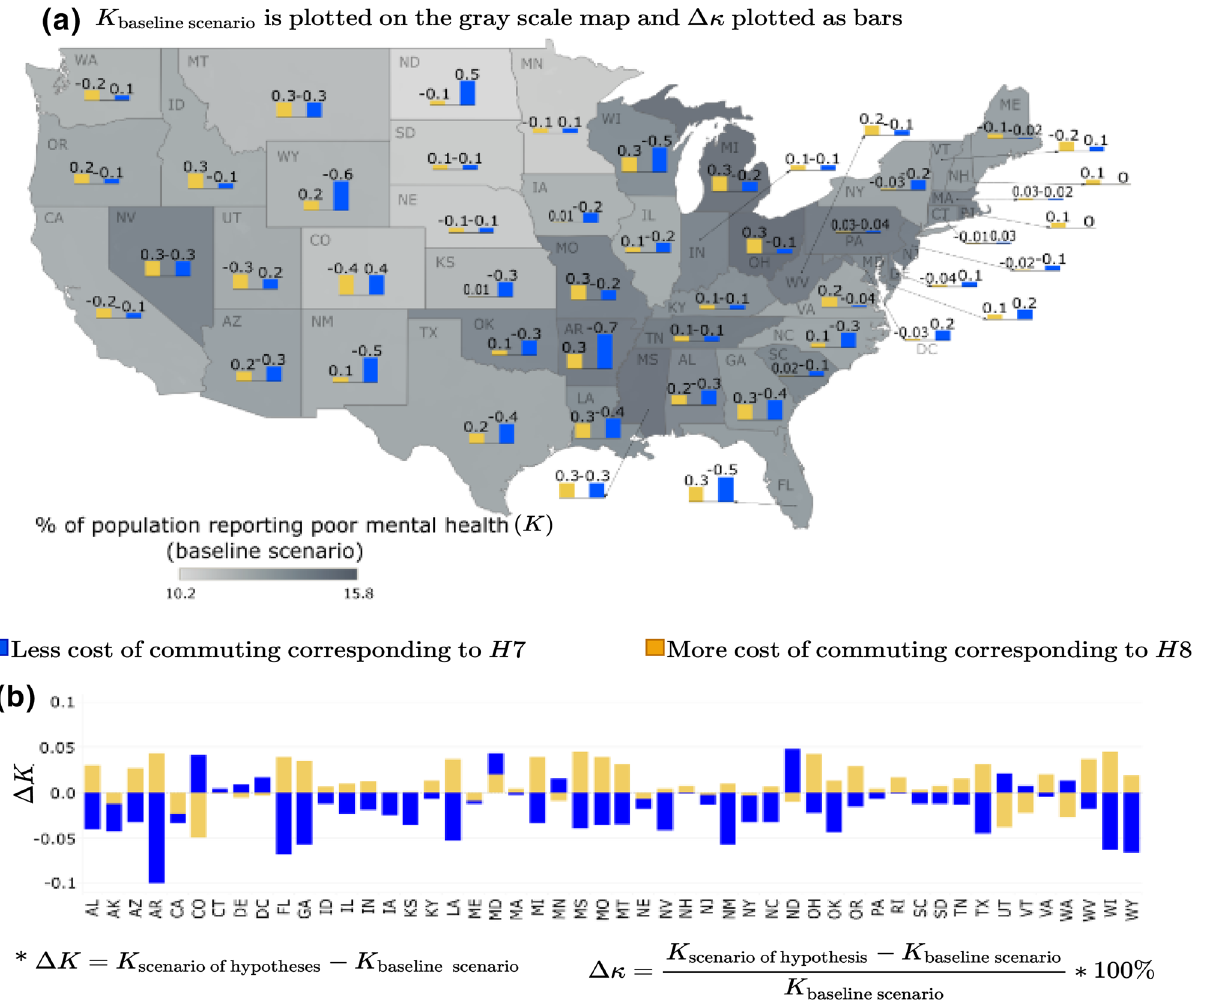
Figure 6. Travel cost scenarios for % of adults aged > 18 years reporting poor mental health for > 14 days ( K ): ( a ) �κ is plotted as the bars and K for base line scenario is plotted as gray scale intensity on the US map; and for ( b ) (cid:31) K is plotted. The maps are created using Tableau 2021.2 (Tableau 2021.2 New Features) and Adobe Illustrator (Software and services for creative business teams | Adobe Creative Cloud for